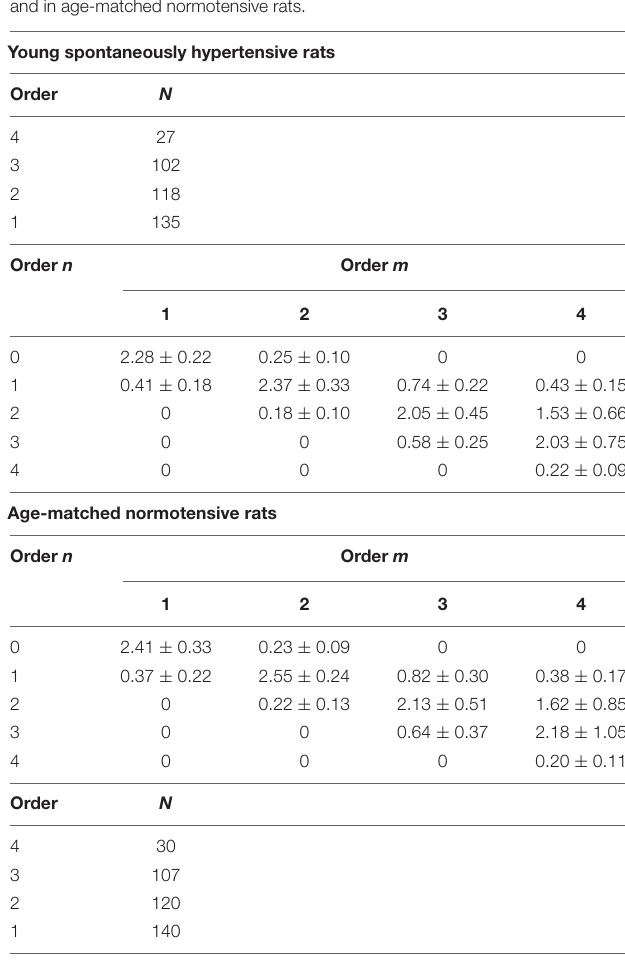
TABLE 4 | Connectivity matrix in young spontaneously hypertensive rats (SHRs) and in age-matched normotensive